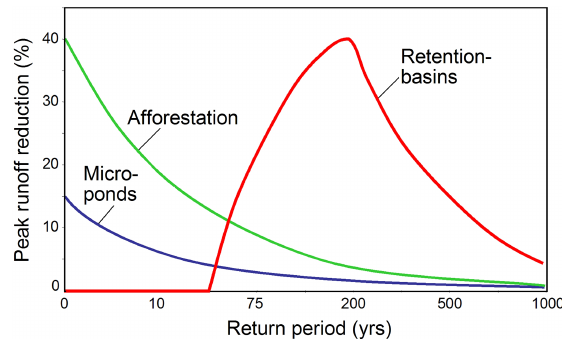
Figure 8. Effect of retention basins, micro-ponds and afforestation on reducing flood peak runoff (schematic). Retention basins typ- ically have little impact on small floods as they pass through the basins without alteration, little impact on the largest floods as the retention basins tend to fill up early in the event, and most impact on medium floods. The effect tends to be largest for small catch- ments that produce short flood events with small runoff volumes (Salazar et al.,